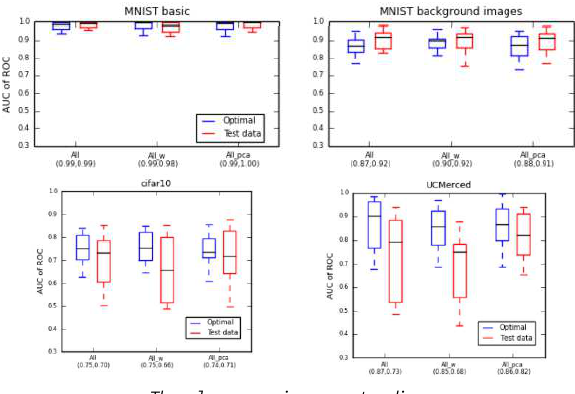
The values on x-axis represent median Figure 8. Performance with Config.2 for each digit/category